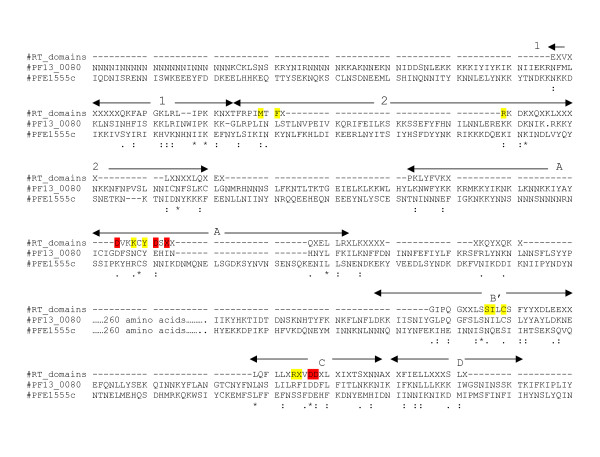
Multiple sequence alignment of conserved RT domains and two potential RT-encoding genes in P. falciparum. #RT_domains is the RT consensus sequence developed in this study. It includes the fingers (1 and 2) and palm (A, B', C and D) domains. #PF13_0080 is the putative PfTERT identified by Figueiredo et al, 2005 [12]. #PFE1555c is a hypothetical protein with similarity to the RT consensus sequence developed in this study. The alignment was performed using ClustalW with default parameters. Residues shaded in yellow have been demonstrated to be in contact with nucleic acid [29]; residues shaded in red are critical for RT activity [30]. * residues common to all threesequences. : conserved residues. . semi-conserved residues